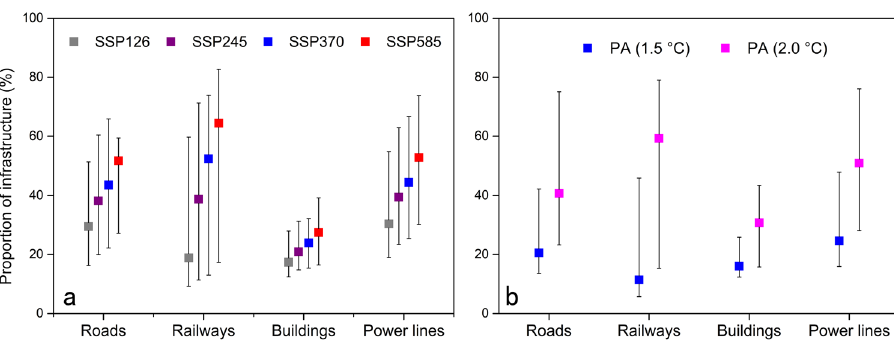
Fig. 2 The proportion of current infrastructure in the high-hazard zone under different scenarios. The mean value (square) with uncertainty ranges (bars) by 2050 (2041 – 2060) under four shared socioeconomic pathways (SSPs) (a) and the target of the Paris Agreement (PA) by the end of this century (b). The uncertainty ranges (bars) were based on the ranges of the mean annual ground temperature and active layer thickness predictions, quanti fi ed using the 97.5th and 2.5th percentiles of the ensemble predicted mean annual ground temperature and active layer thickness with 200 runs.